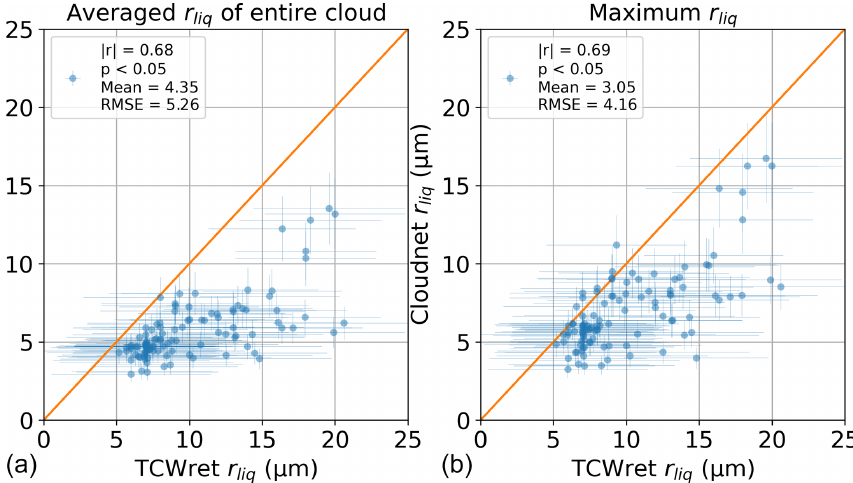
Figure 12. The r liq of TCWret versus r liq of Cloudnet averaged over the entire cloud (a) and maximum value of the cloud from Cloudnet (b)